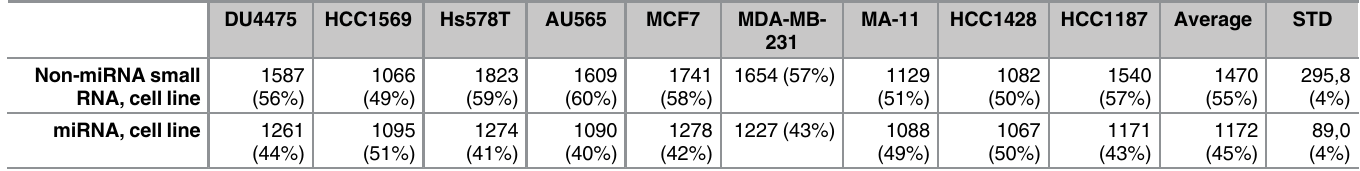
Table 2. Number of unique non-miRNA small RNAs and miRNAs (tags) detected in the nine breast cancer cell